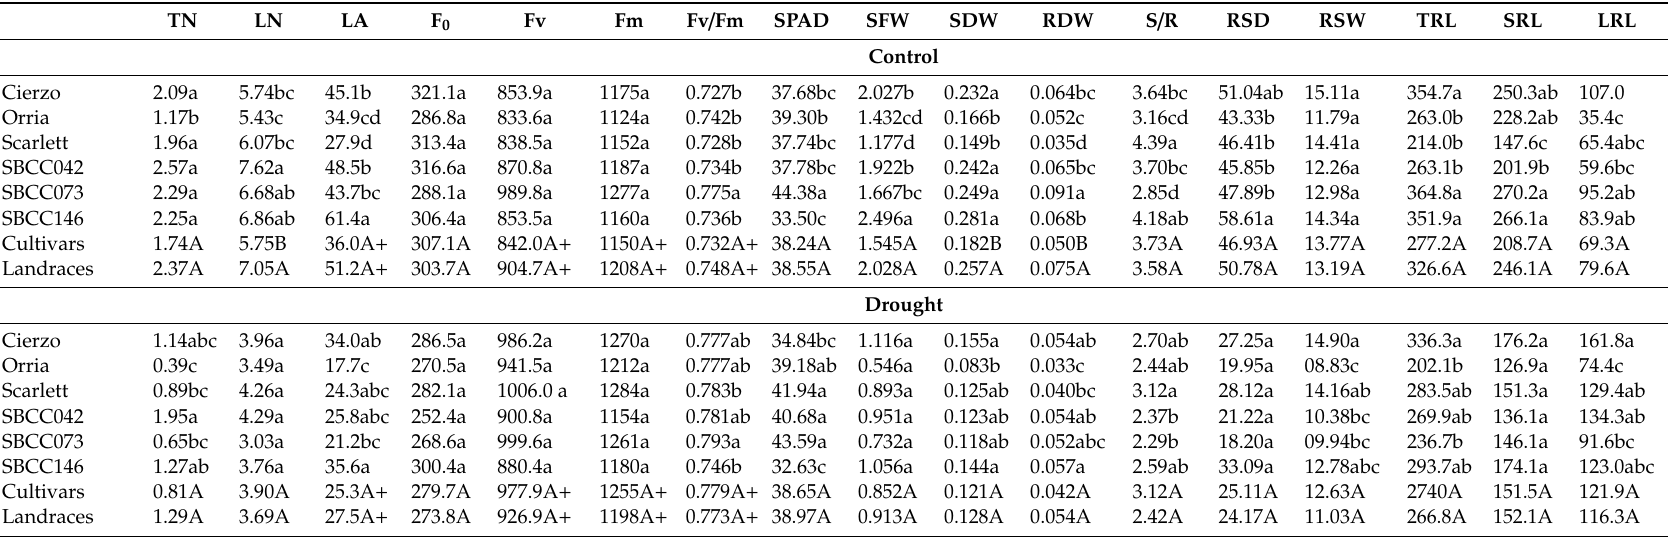
Table 2. Means and means’ comparison for di ff erent traits measured in six barley genotypes, under control and drought conditions in rhizoboxes, at the end of the four weeks’ experiment. Cultivars is an average of Cierzo, Orria, and Scarlett. Landraces is an average of SBCC042, SBCC073, and